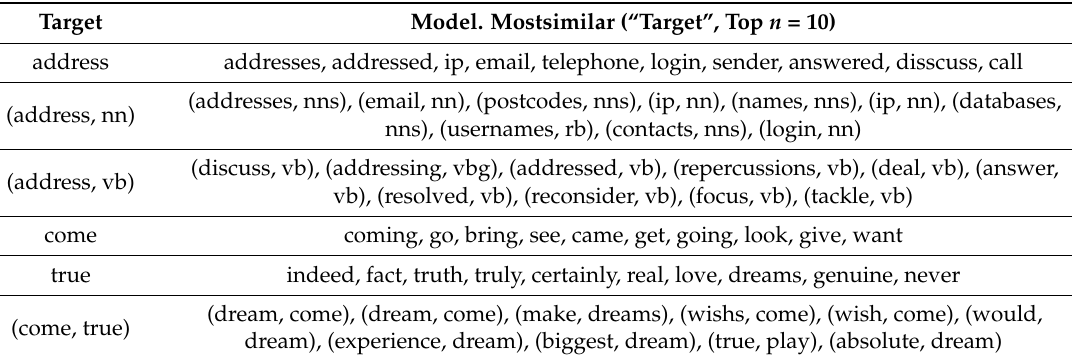
Table 1. Most similar word/N-gram to the target word/N-gram in embedding models. Target Model. Mostsimilar (“Target”, Top n =